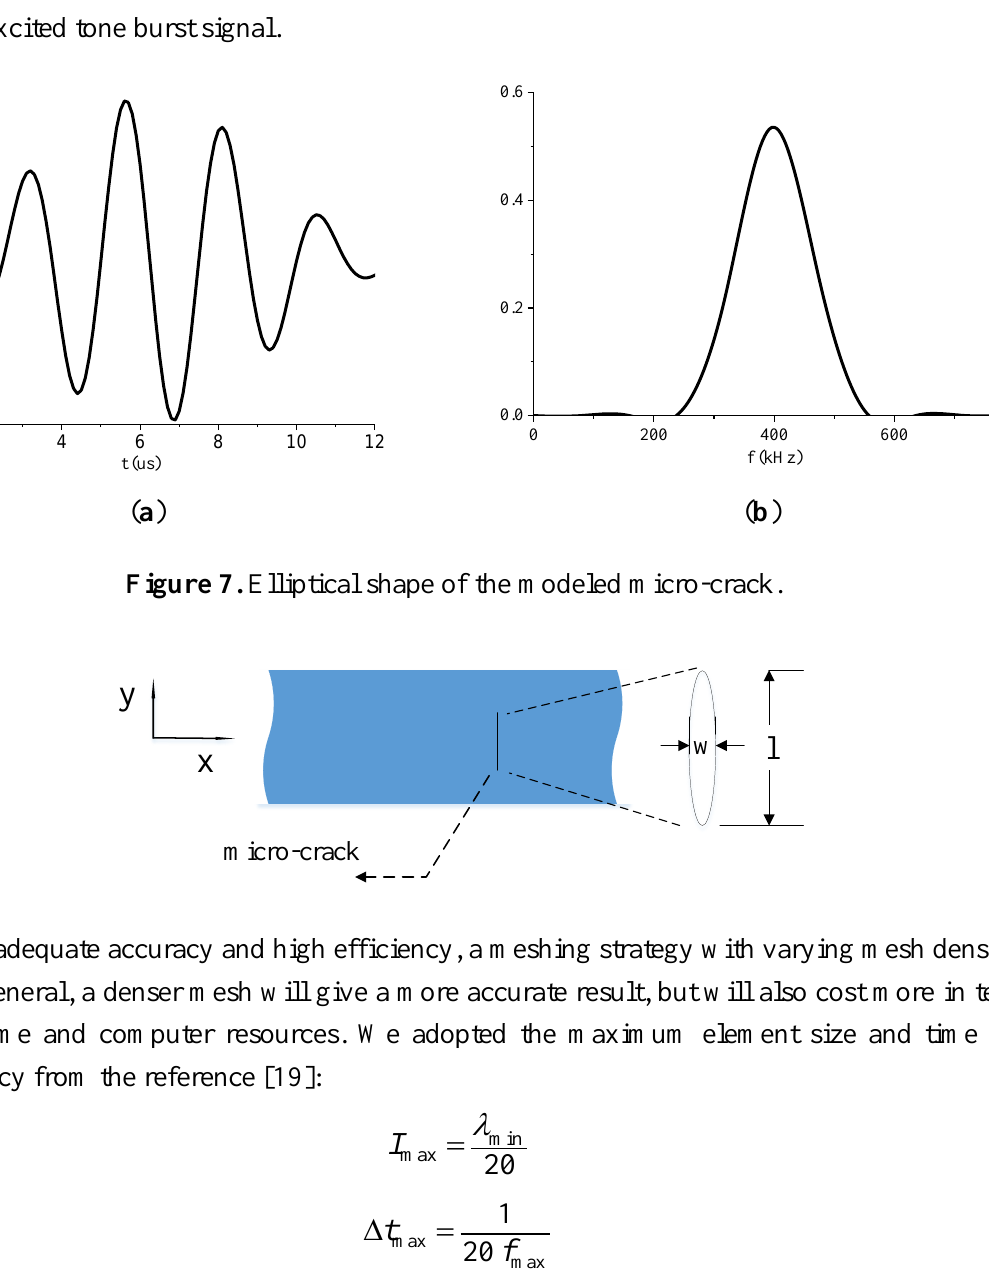
Figure 6. ( a ) Temporal waveform of the excited tone burst signal. ( b ) Frequency spectrum of the excited tone burst signal.